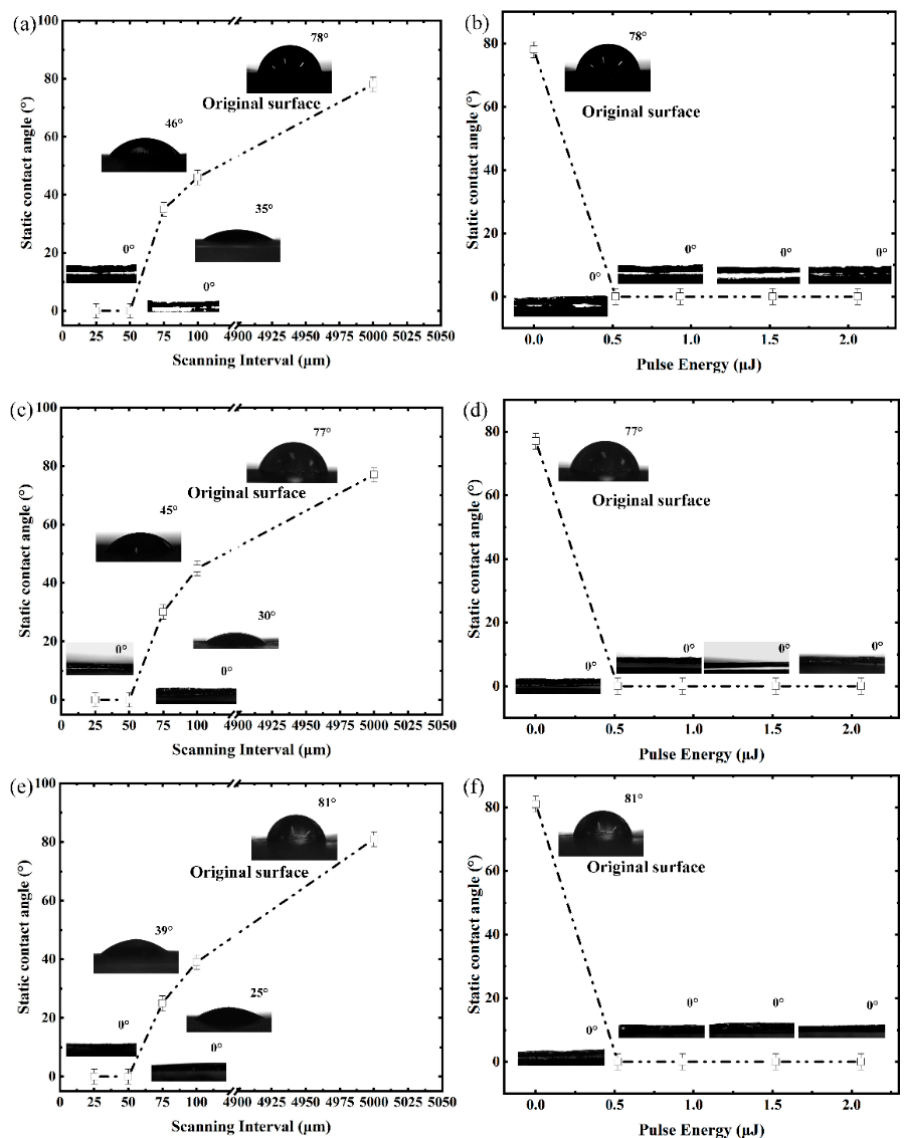
Figure 5. Dependence of the static contact angles on scanning interval at ( a ) 25 °C ( c ) 80 °C ( e ) 3 °C and dependence of the static contact angles on pulse energy at ( b ) 25 °C ( d ) 80 °C ( f ) 3